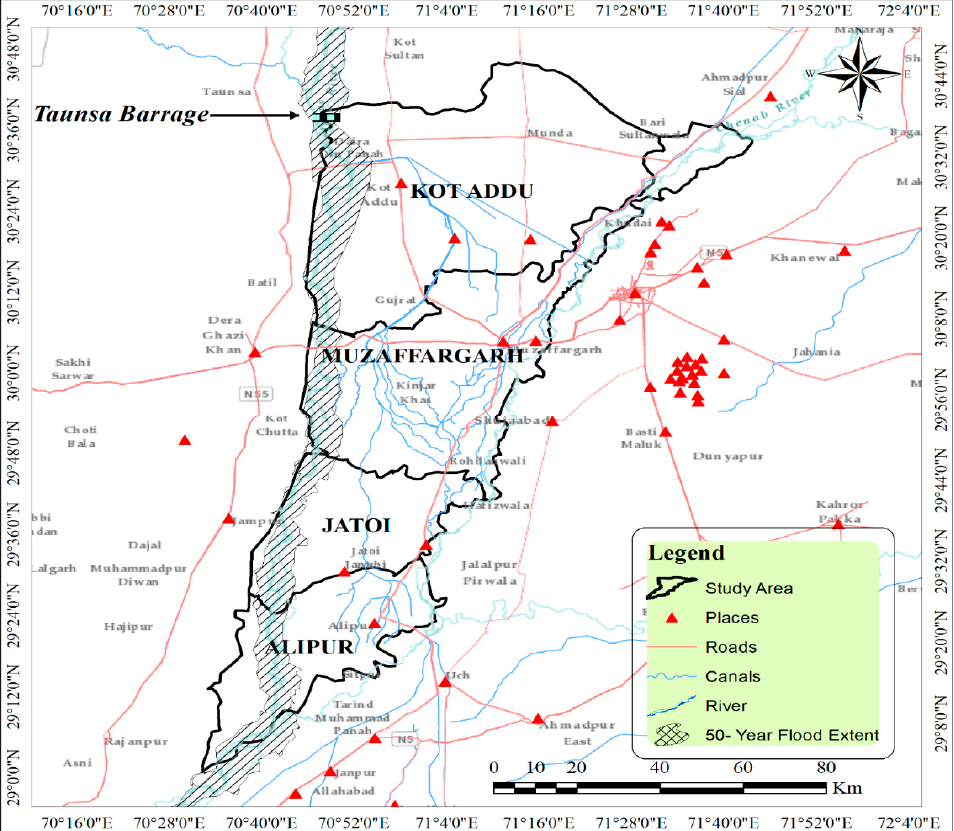
Figure 8. Areas in the Muzaffargarh District expected to be flooded for a flood with a 50-year return period.